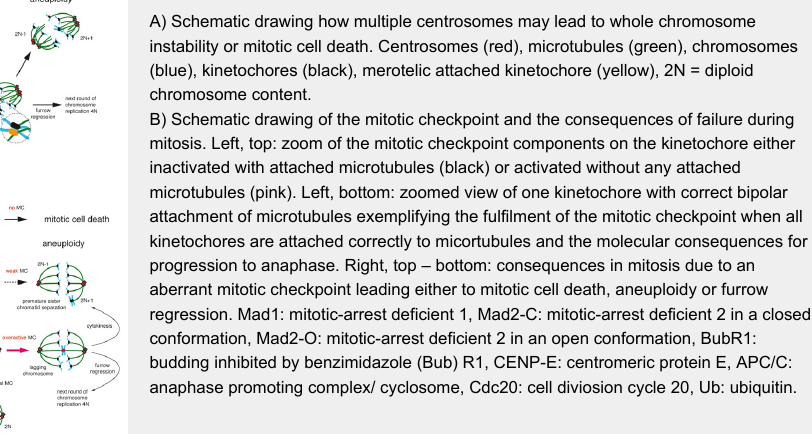
A) Schematic drawing how multiple centrosomes may lead to whole chromosome instability or mitotic cell death. Centrosomes (red), microtubules (green), chromosomes (blue), kinetochores (black), merotelic attached kinetochore (yellow), 2N = diploid chromosome content. B) Schematic drawing of the mitotic checkpoint and the consequences of failure during mitosis. Left, top: zoom of the mitotic checkpoint components on the kinetochore either inactivated with attached microtubules (black) or activated without any attached microtubules (pink). Left, bottom: zoomed view of one kinetochore with correct bipolar attachment of microtubules exemplifying the fulfilment of the mitotic checkpoint when all kinetochores are attached correctly to micortubules and the molecular consequences for progression to anaphase. Right, top – bottom: consequences in mitosis due to an aberrant mitotic checkpoint leading either to mitotic cell death, aneuploidy or furrow regression. Mad1: mitotic-arrest deficient 1, Mad2-C: mitotic-arrest deficient 2 in a closed conformation, Mad2-O: mitotic-arrest deficient 2 in an open conformation, BubR1: budding inhibited by benzimidazole (Bub) R1, CENP-E: centromeric protein E, APC/C: anaphase promoting complex/ cyclosome, Cdc20: cell diviosion cycle 20, Ub: